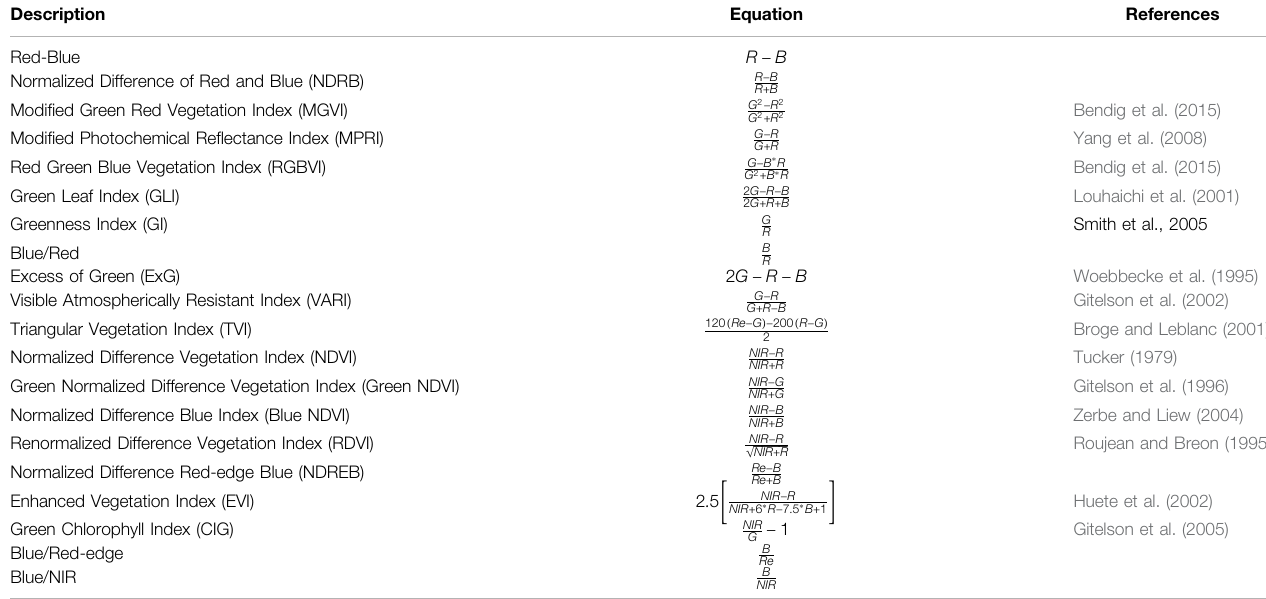
TABLE 1 | Blue (B), green (G), red (R), red-edge (Re), and near infrared (NIR) band combinations for each of the vegetation indices tested for the separability analysis of kelp and water